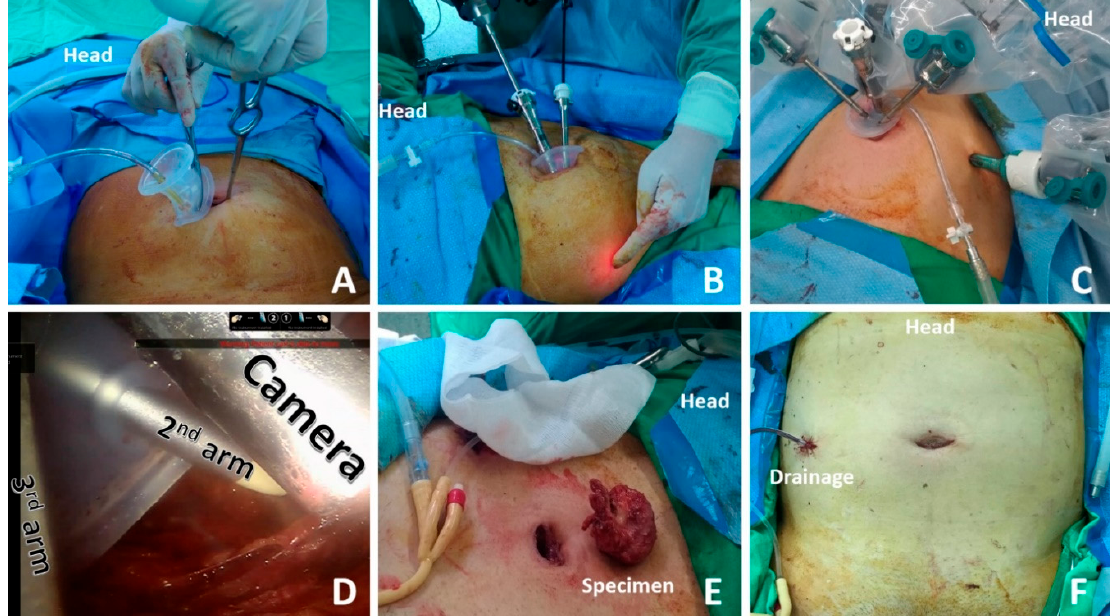
Figure 1. The single-site port was introduced into the space carefully using a blunt Kelly forceps ( A ). An additional 8 mm or 11 mm port was then introduced ( B , C ). Single-site port with camera and two working arms ( D ). Specimens could be easily withdrawn from the umbilicus wound directly when the prostate volume was less than 40 mL ( E ). A Jackson–Pratt drain was placed in the pelvic cavity through the additional right abdominal port ( F ).